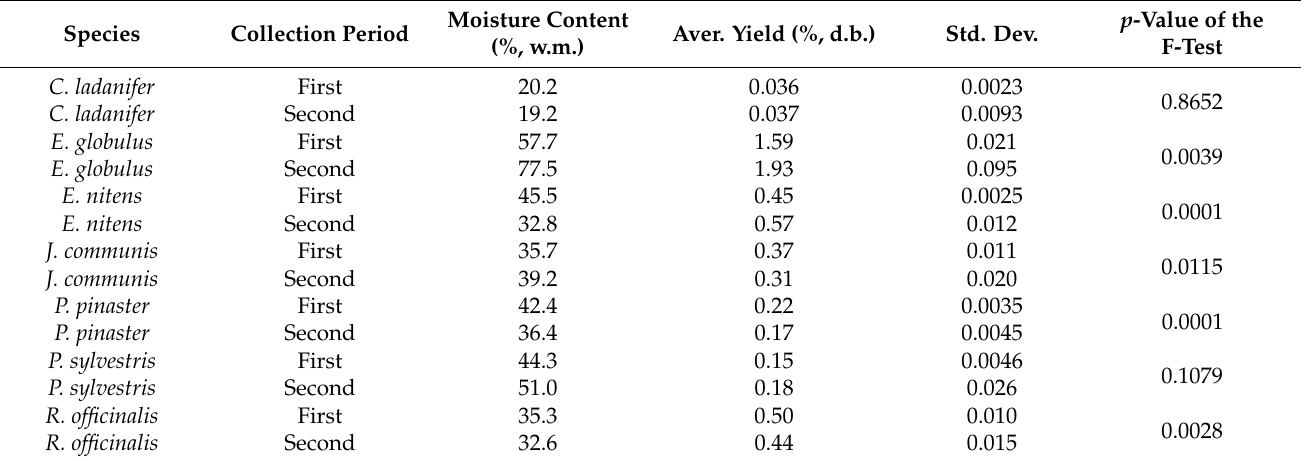
Table 1. Essential oil yields obtained in the steam distillation